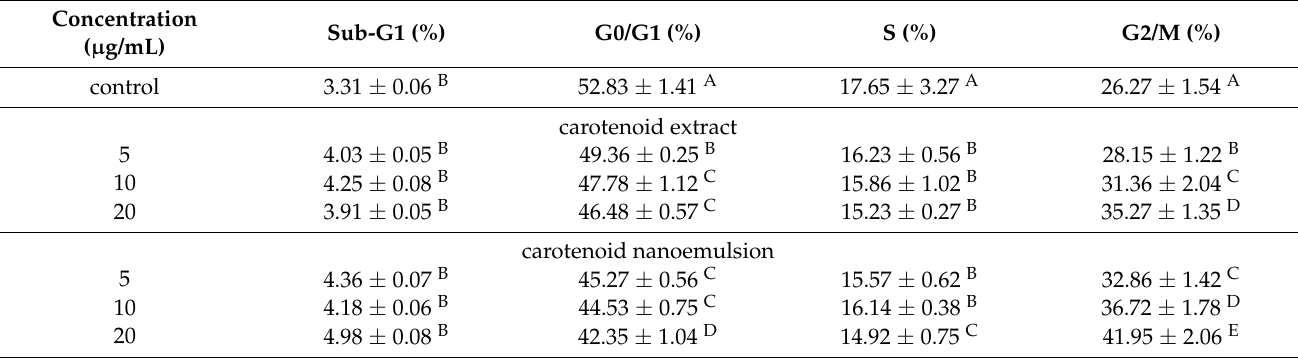
Table 2. Cell-cycle distribution of melanoma cells A375 as affected by carotenoid extracts and nanoemulsions 1,2 . Concentration ( µ